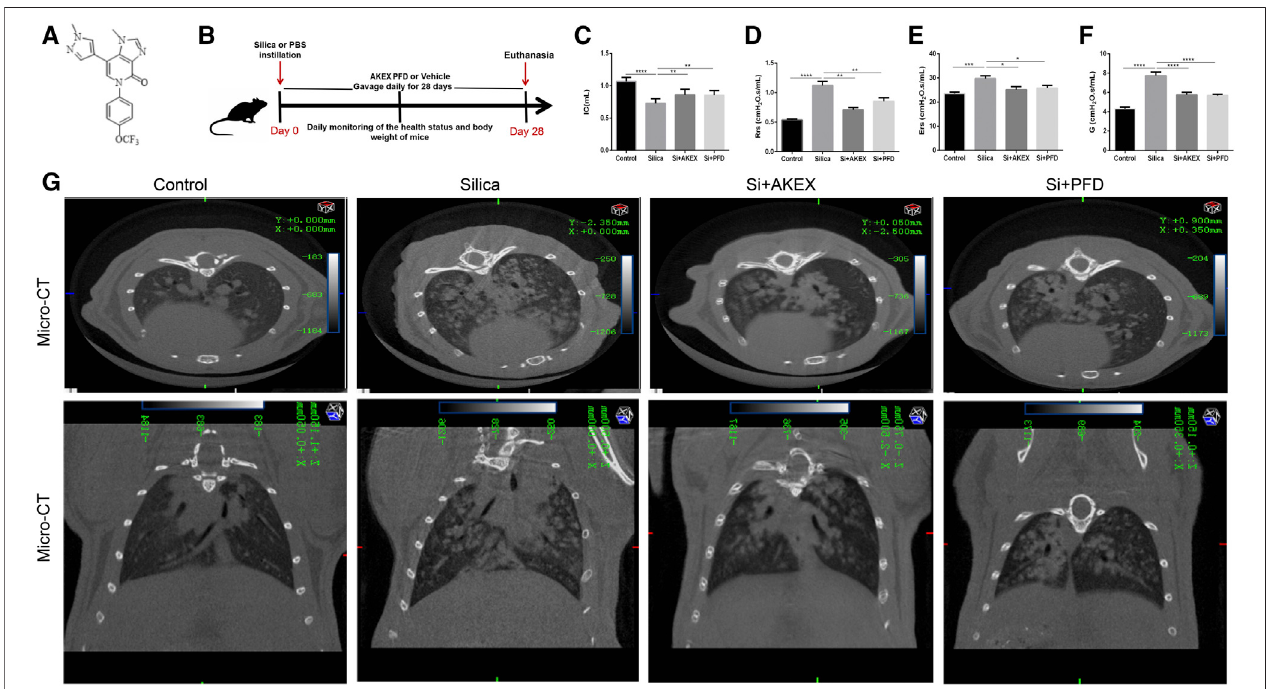
FIGURE 1 | AKEX0011 ameliorated lung dysfunction in the early therapeutic silicosis model. (A) Chemical structure of AKEX0011 (B) Experimental outline of AKEX0011 treatment in the early therapeutic silicosis model. There were four experimental groups: PBS control (abbreviated as “ Control ” in the graphs), silica + vehicle (abbreviated as “ Silica ” ), silica + AKEX0011 (abbreviated as “ Si + AKEX ” ), and silica + PFD (abbreviated as “ Si + PFD ” ) in the following experiments of Figures 1 and Figure 4 . Silicosis mouse models were established via intratracheal instillation ofsilica suspension (orPBS in control animals). Mice were gavaged with AKEX0011 BID, PFD BID, or vehicle BID after silica instillation and maintained for 28 days; then, they were euthanized at day 28. (C-F) Lung function parameters improvement: IC, inspiratorycapacity(n=9-10);Rrs,respiratoryresistance(n=8-9);Ers,elasticresistance(n=8-10);andG,tissuedamping(n=5-9). (G) Chestmicro-CTscans.Alldata were presented as mean ± SEM; * p < 0.05, ** p < 0.01, *** p < 0.001, **** p <